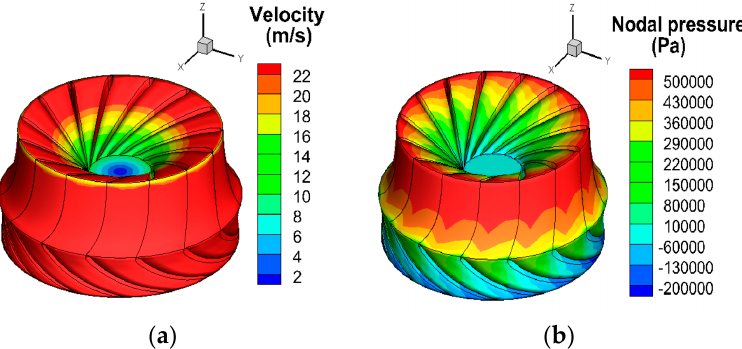
Figure 7. Velocity and pressure distribution in the runner. ( a ) Velocity contour, ( b ) pressure contour.